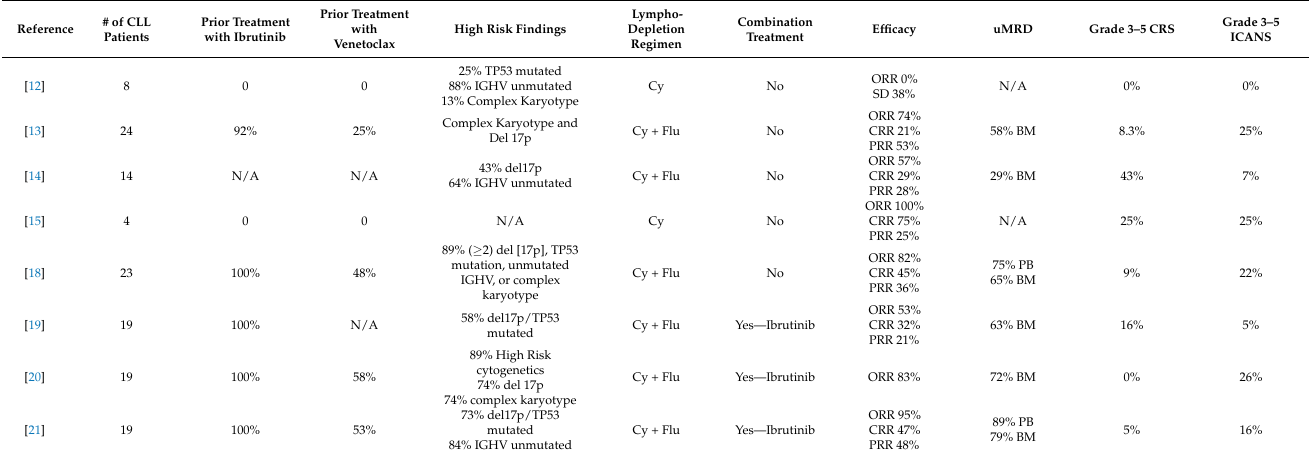
Table 1. Summary of key clinical trials of CD19 directed CAR T cells for patients with